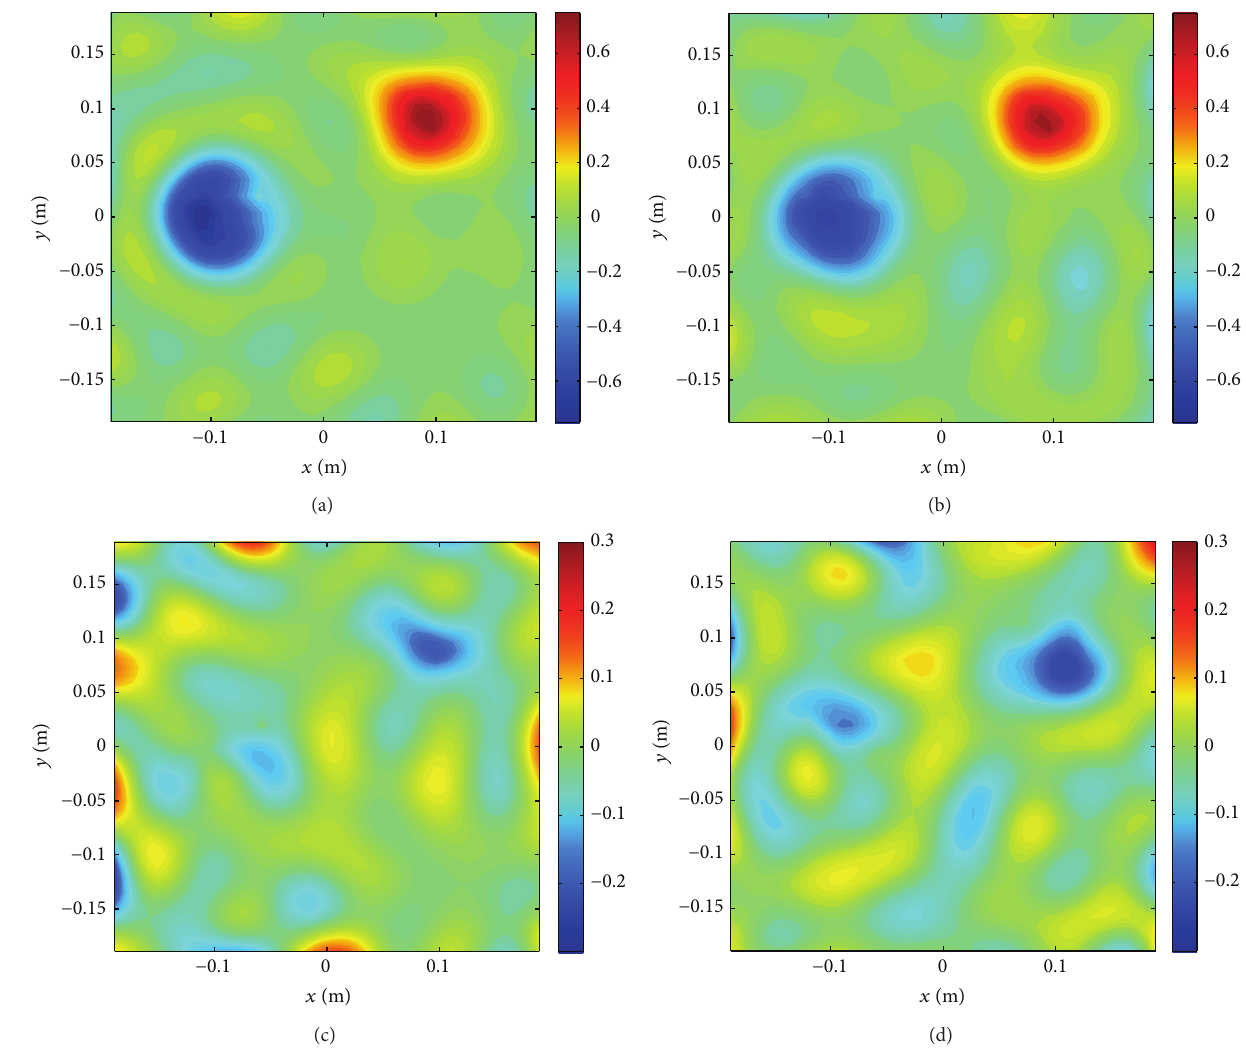
Figure 10: Example 1: QLSM reconstructions by using measurement configuration B. ((a), (c)) Real and imaginary parts of retrieved profiles in a square scanner; ((b), (d)) real and imaginary parts of retrieved profiles in a triangular scanner.